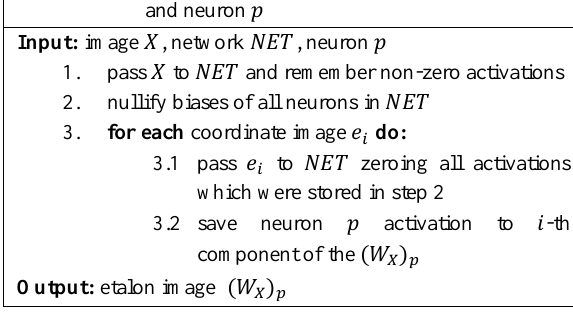
Figure 3. Etalon reconstruction algorithm for input image 𝑋 and neuron 𝑝